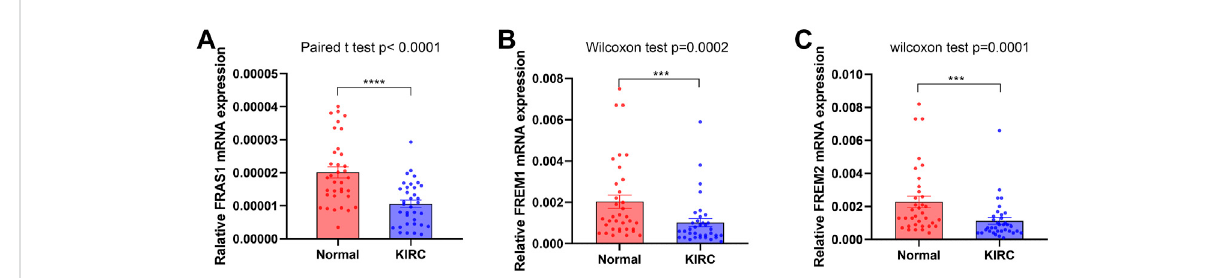
FIGURE 3 FRAS1/FREM expression in cancer and adjacent normal kidney tissues of KIRC patients by RT-PCR. (A) FRAS1 expression in cancer and adjacent normal kidney tissues of KIRC patients. (B) FREM1 expression in cancer and adjacent normal kidney tissues of KIRC patients. (C) FREM2 expression in cancer and adjacent normal kidney tissues of KIRC